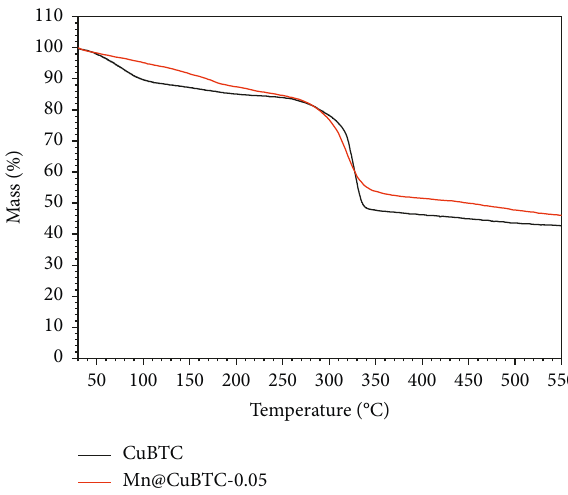
Figure 5: TG curves showing the mass loss as a function of temperature in the range of 30 ° C to 550 ° C, obtained from as- prepared CuBTC and Mn@CuBTC-0.05